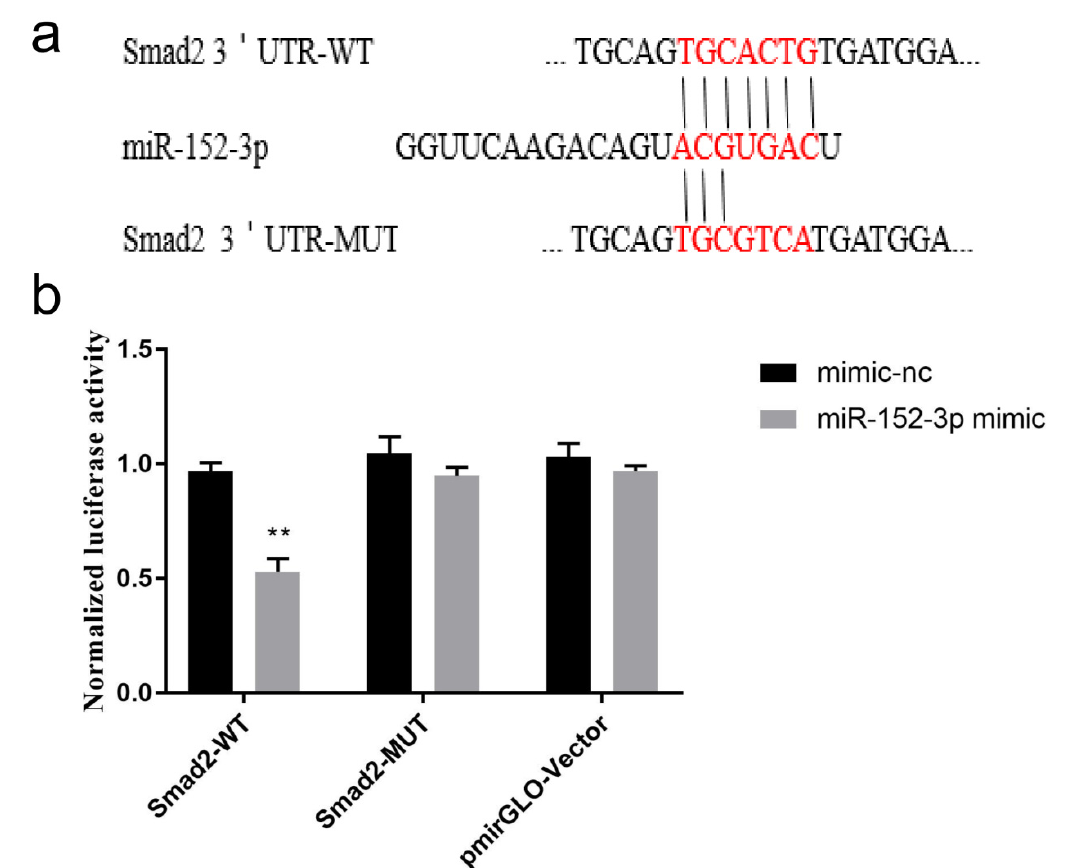
Figure 5. The direct target gene of miR-152-3p is Smad2. ( a ) The binding sites and mutant bases of miR-152-3p and Smad2 3 ′ UTR. ( b ) Luciferase activity of the recombinant plasmids pmirGLO– Smad2 -3 ′ UTR-WT or pmirGLO– Smad2 -3 ′ UTR-MUT co-transfection with the miR-152-3p mimic. The RT-qPCR data were normalized to the level of U6. Data were expressed as mean ± SD for three biological replicates (Student’s t -test: **, p < 0.01).